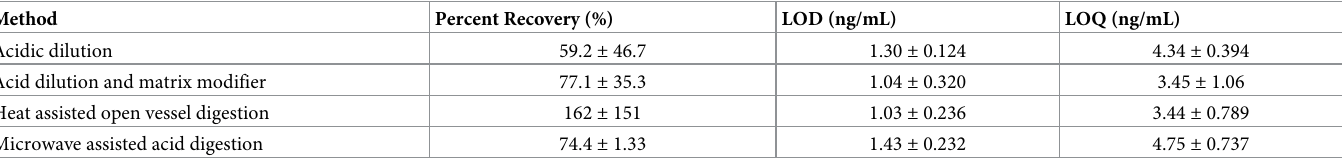
Table 3. Performance of the four sample preparation methods for lead detection in E . Coli .